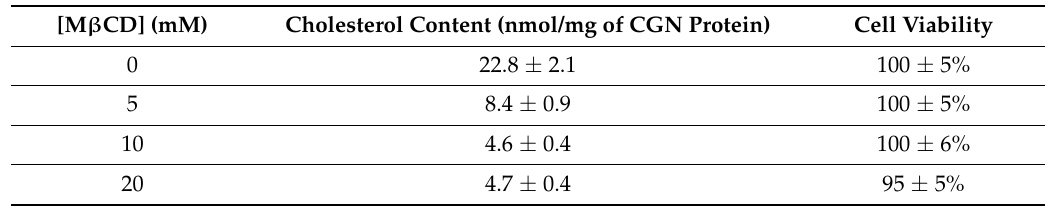
Table 1. A short-term incubation with methyl- β -cyclodextrin (M β CD) efficiently extracts cholesterol from cerebellar granule neurons (CGNs) while preserving cell